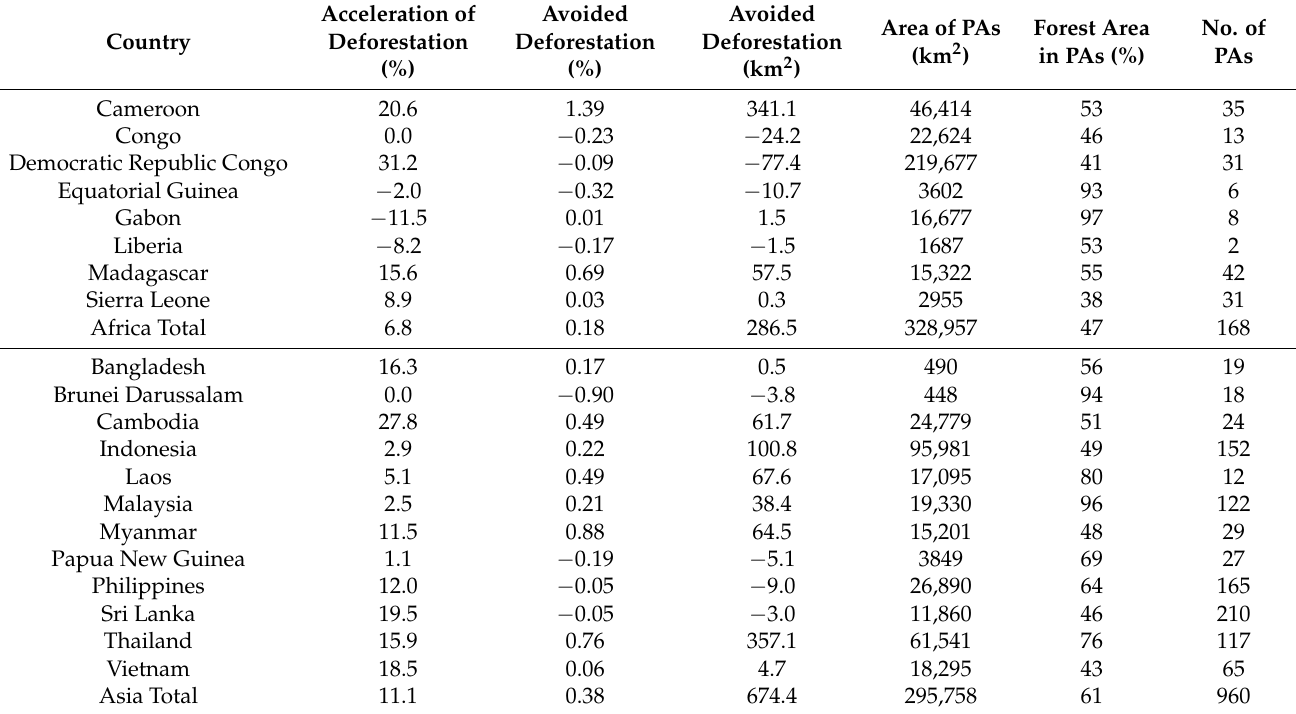
Table A1. Summary of the avoided deforestation estimates by countries and continents. Acceleration of deforestation is indicated by percent increase in net deforestation rate from the 1990s to the 2000s (3). Avoided deforestation is presented in percent of conserved forest relative to remaining forest in PAs and total area of conserved forest. All estimates are on an annual basis. Negative effect means forest loss rates within PAs exceeded the forest loss rates in surrounding